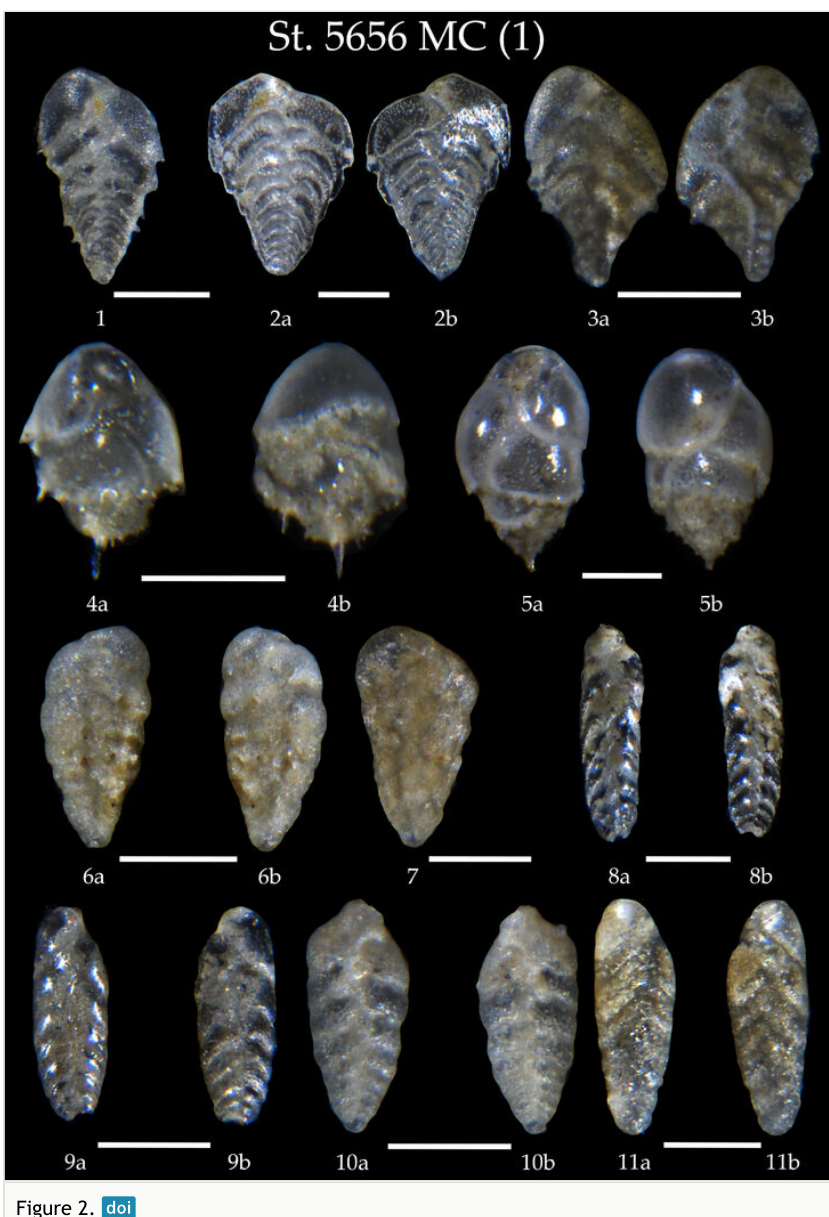
Figure 2. Station 5656 MC . 1 Brizalina pygmaea ; 2 Brizalina alata , a , b lateral view; 3 Bolivina tortuosa ; 4 Bulimina aculeata , a apertural view, b lateral view; 5 Bulimina marginata , a apertural view, b lateral view; 6 Bolivina pseudoplicata , 6a side view, 6b lateral view; 7 Bolivina pseudoplicata ; 8 , 9 Bolivina earlandi , a side view, b lateral view; 10 , 11 Bolivina striatula , a side view, b lateral view. Scale 100